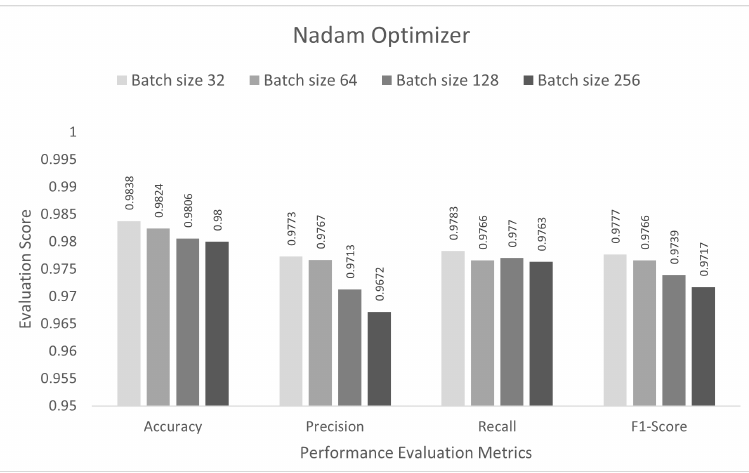
Figure 7. Nadam optimizer for multi-class category classification scenario.